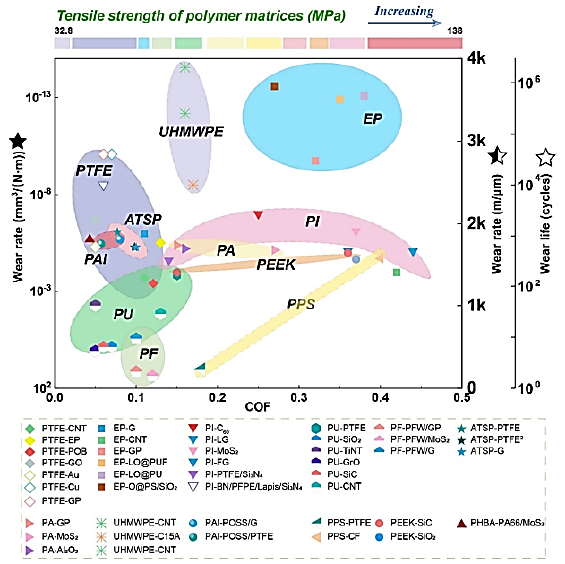
Figure 2. The tribological properties of different polymer matrices and fillers. Figure is reproduced with permission from reference [7]. with permission from reference